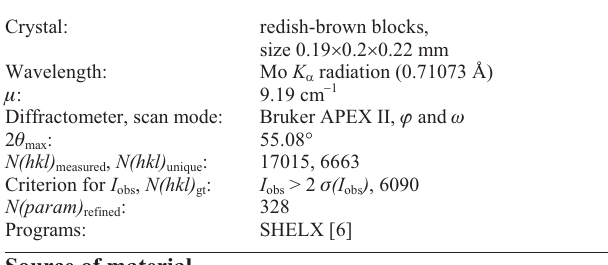
Table 1. Data collection and handling.